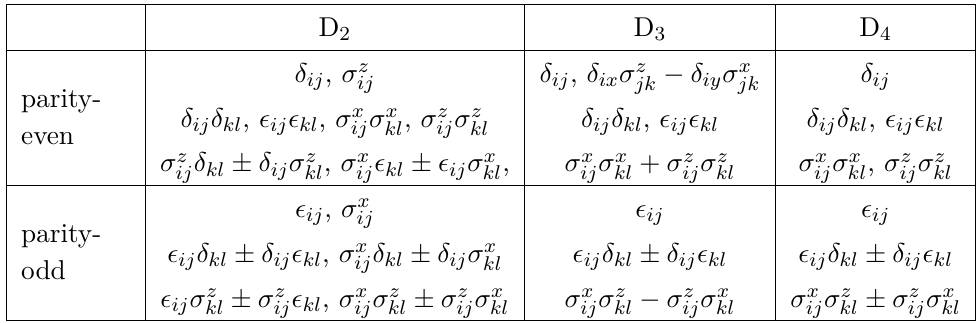
Lists of invariant n -tensors for various discrete rotational groups even or odd under parity symmetry. The 3-tensor for D 3 is chosen to respect P y ; see the main